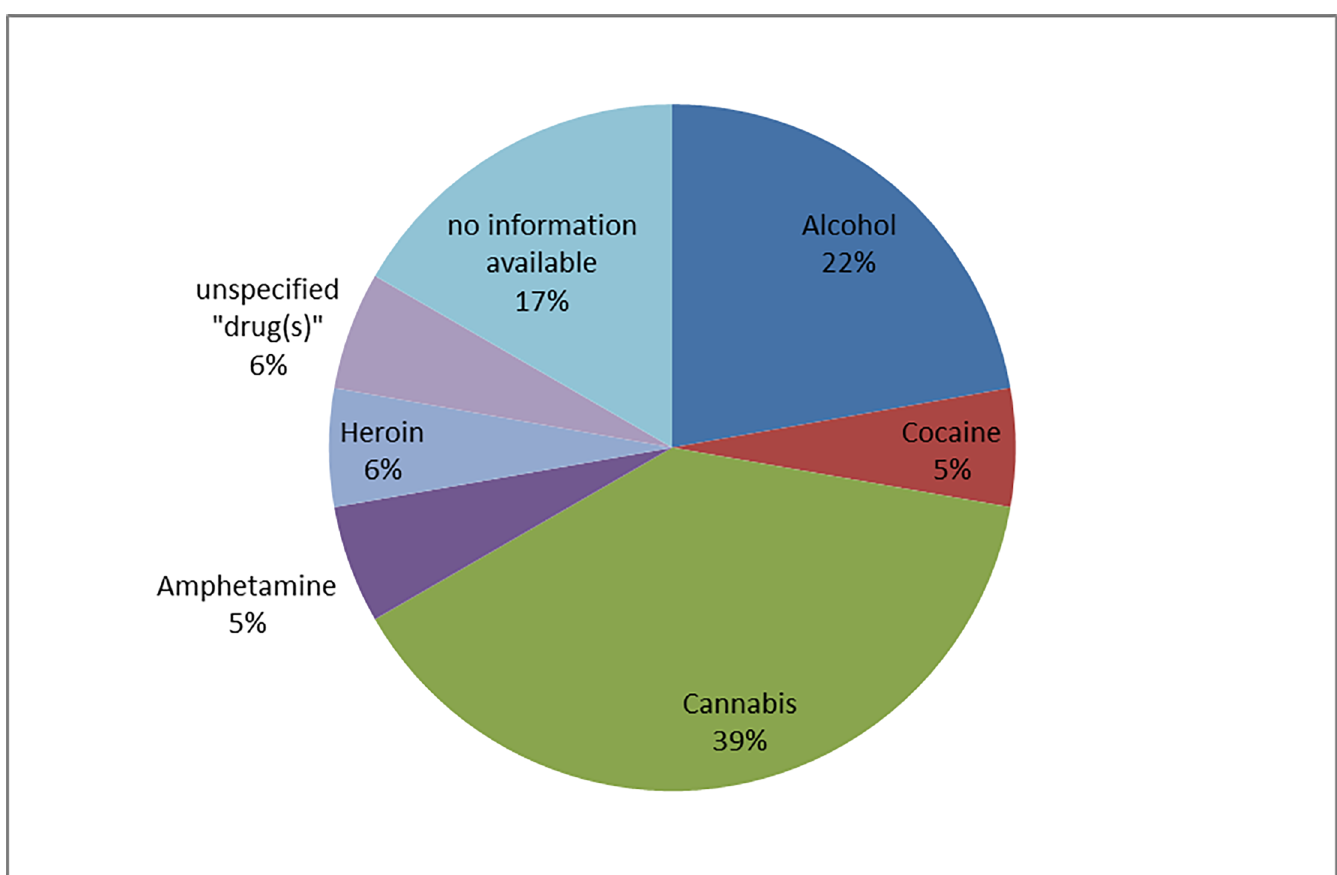
Fig 7. Reported substance use in cases of domestic violence (n =